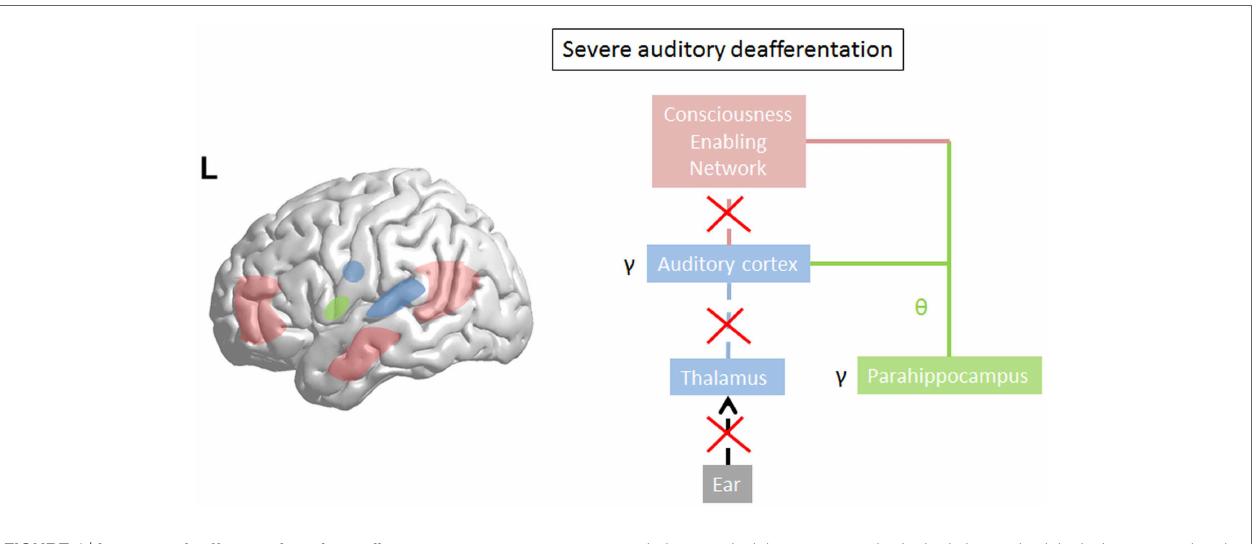
FiGuRe 4 | in severe deafferentation, the auditory cortex cannot retrieve the missing auditory input from the (auditory) cortical neighborhood . The thalamocortical bursting theta activity in the auditory cortex recruits the missing auditory input from the most recent update from parahippocampal-mediated memory processing (green line). There is no more